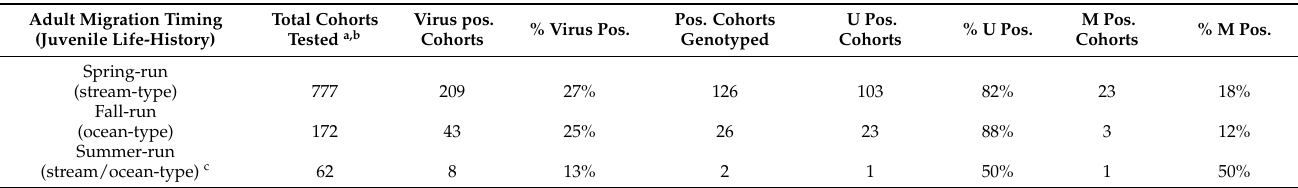
Table 7. Prevalence of U and M IHNV infection in spring-run, fall-run, and summer-run Chinook salmon of the CRB during the years